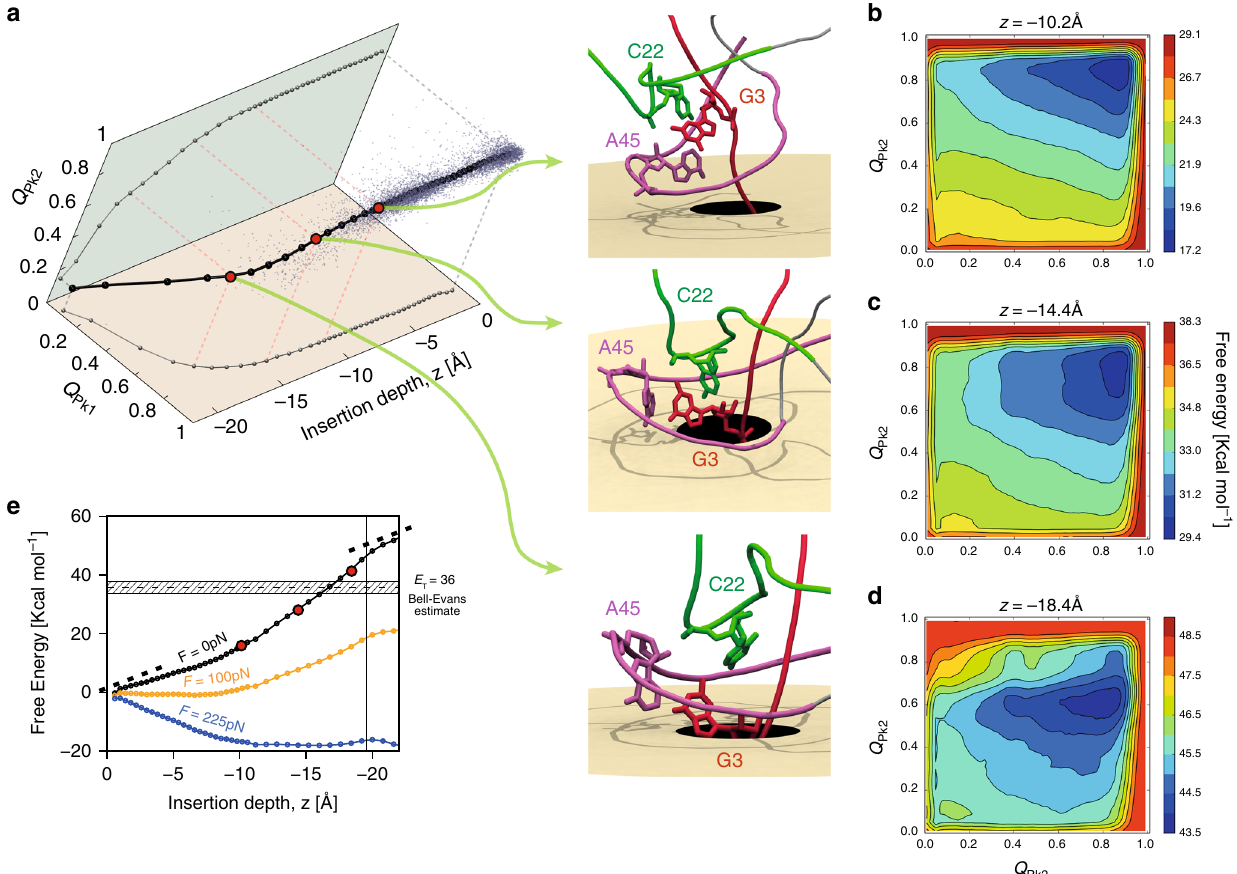
Fig. 5 Free-energy pro fi ling of Zika xrRNA translocation. a Dominant translocation pathway, from metadynamics analysis, showing the fraction of native contacts, Q Pk1 and Q Pk2 , versus z , the pore insertion depth of the 5 0 P atom. Its projections in the ( Q Pk1 , z ) and ( Q Pk2 , z ) planes are also shown. The cloud of points shows instantaneous values of the same order parameters in force-ramped translocations at T = 300 K and r = r 0 . Representative snapshots at marked values of z (red dots) are shown. b – d Sections of the three-dimensional metadynamics free-energy at the same marked values of z . e One- dimensional free-energy pro fi le, obtained from thermodynamic integration and reweighting at the indicated translocation forces. The estimated uncertainty is about 0.55 kcal mol − 1